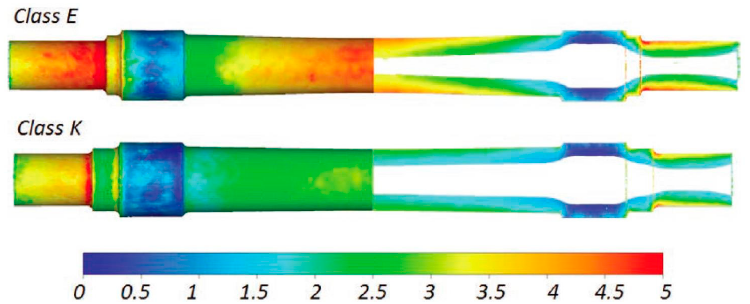
Figure 11. Numerically simulated distribution of effective strain in cross-rolled rail axles [10] (Reprinted from ref. [10]).